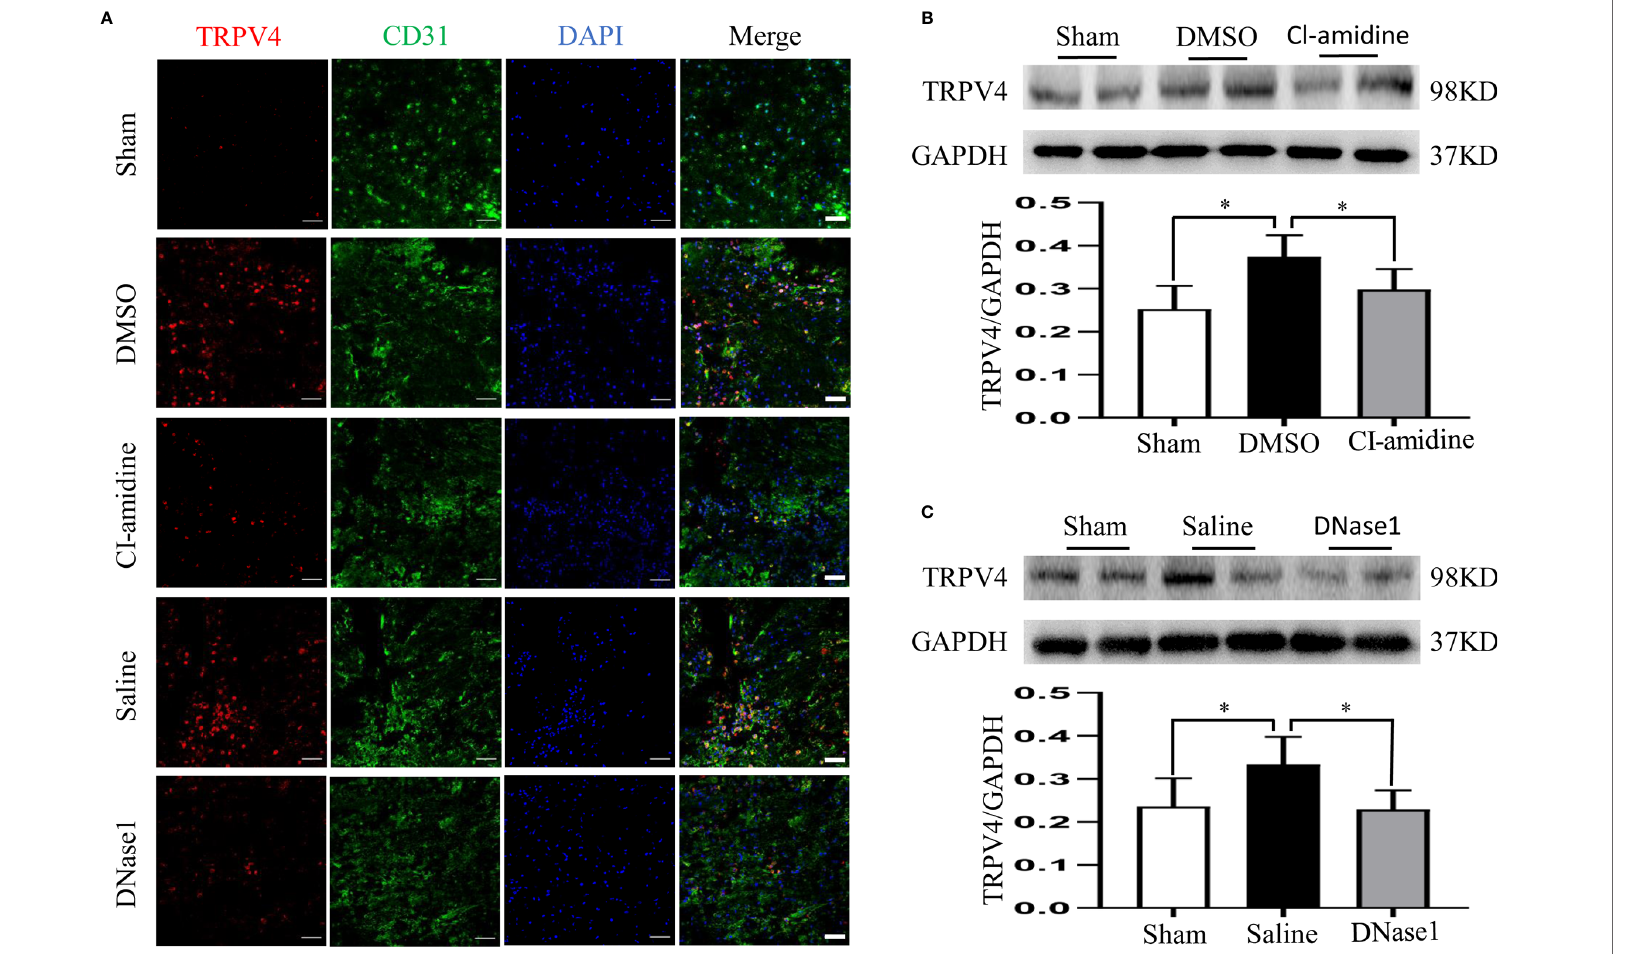
FIGURE 9 | NETs promote BSCB disruption through elevating TRPV4. (A) Representative images of TRPV4 (red) and CD31 (green) double-positive cells at the injury epicenter of each group at 24 h after operation. Nuclear was marked with DAPI (blue). Scale bars = 50 m m. (B, C) Representative immunoblots and quanti fi cation of TRPV4 levels in injured spinal cord of each group at 24 h after operation. Data are presented as means ± SD of n = 6 (* p <